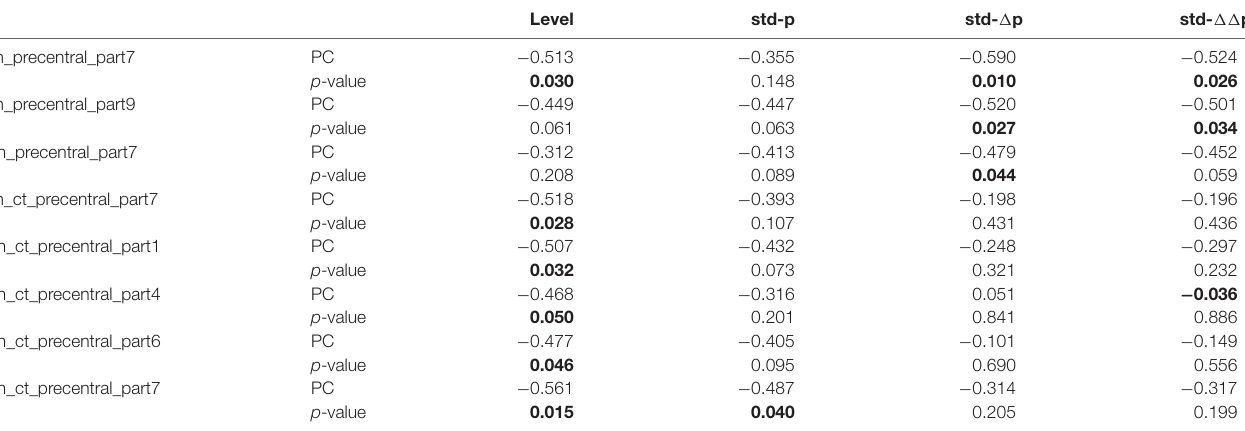
TABLE 3 | Significant areas in Pearson’s partial correlation (PC) analysis with brain volume correction for the motor cortex (DSK 308 parcellation); significant values for p -value < 0.01 and p -value < 0.05 (bilateral): CV and CT. Level std-p std- ∆ p std- ∆∆